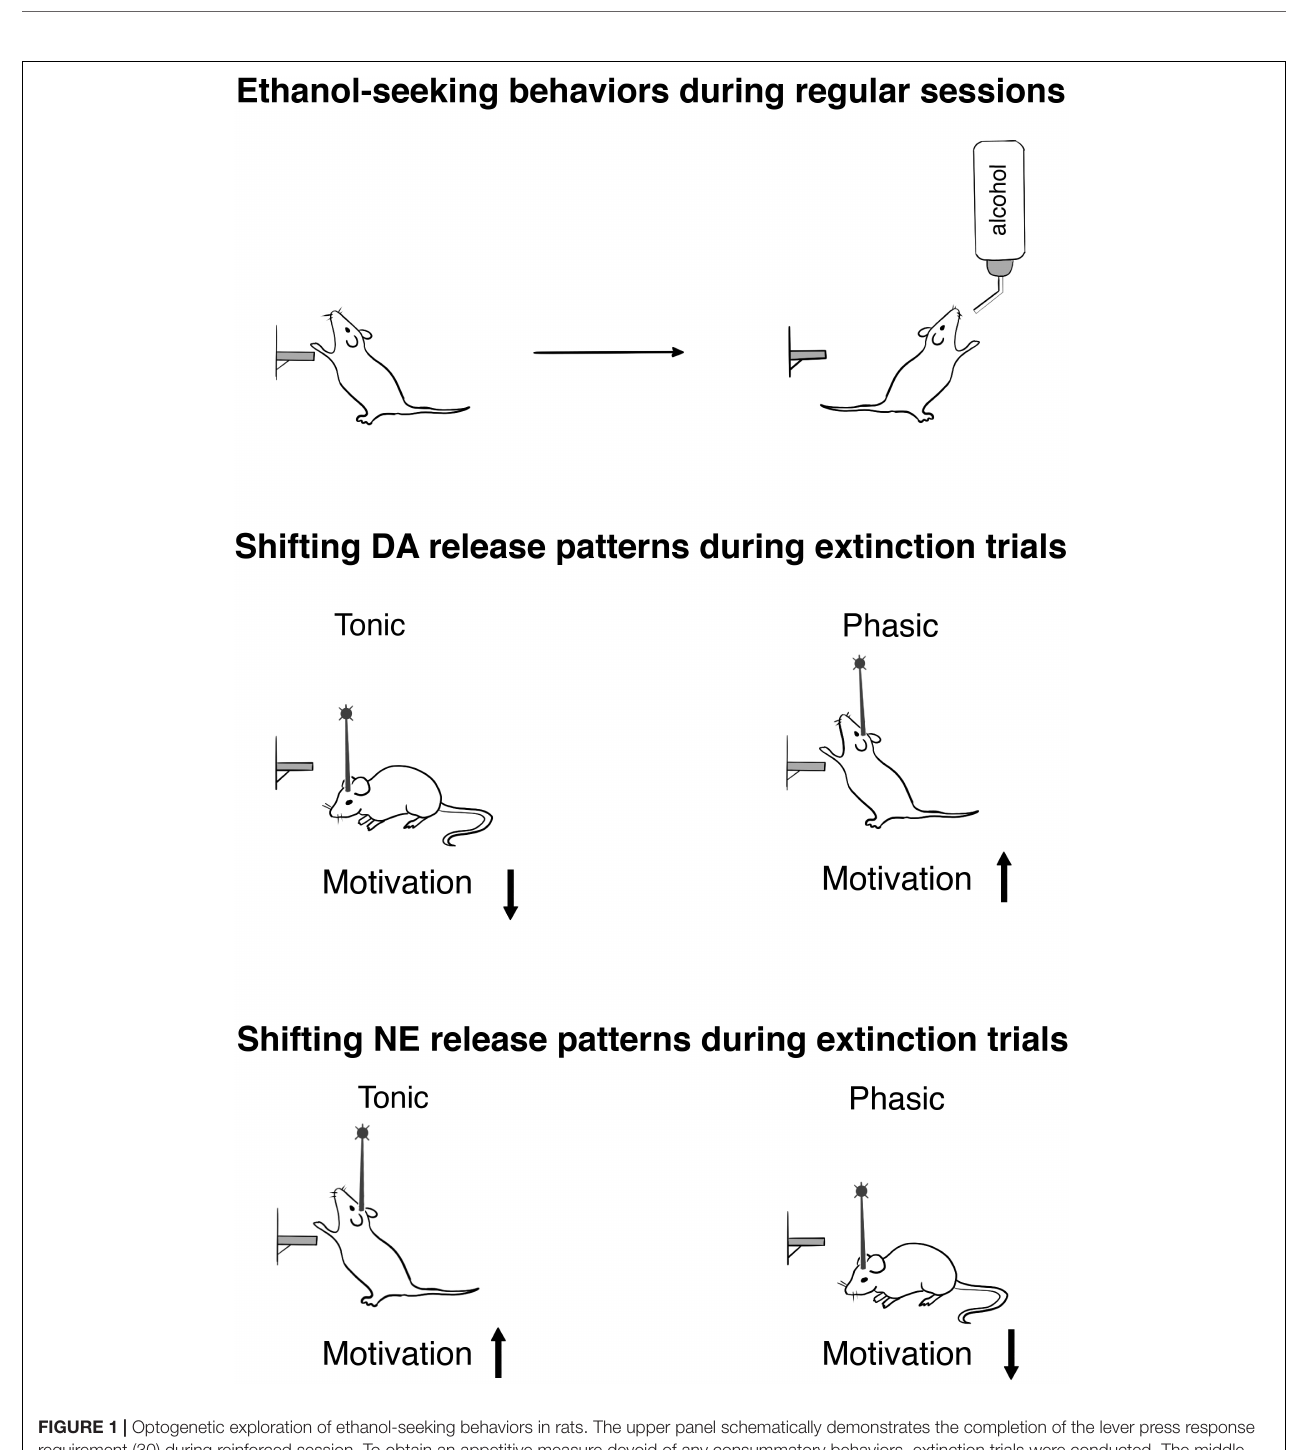
FIGURE 1 | Optogenetic exploration of ethanol-seeking behaviors in rats. The upper panel schematically demonstrates the completion of the lever press response requirement (30) during reinforced session. To obtain an appetitive measure devoid of any consummatory behaviors, extinction trials were conducted. The middle panel shows how optogenetic shifting of the VTA-nucleus accumbens DA release into the tonic and phasic patterns affects the motivation to obtain ethanol during extinction trials (for details, see Budygin et al., 2020). The lower panel indicates motivational changes resulting from the patterns of the LC-NE release (for details, see Deal et al.,